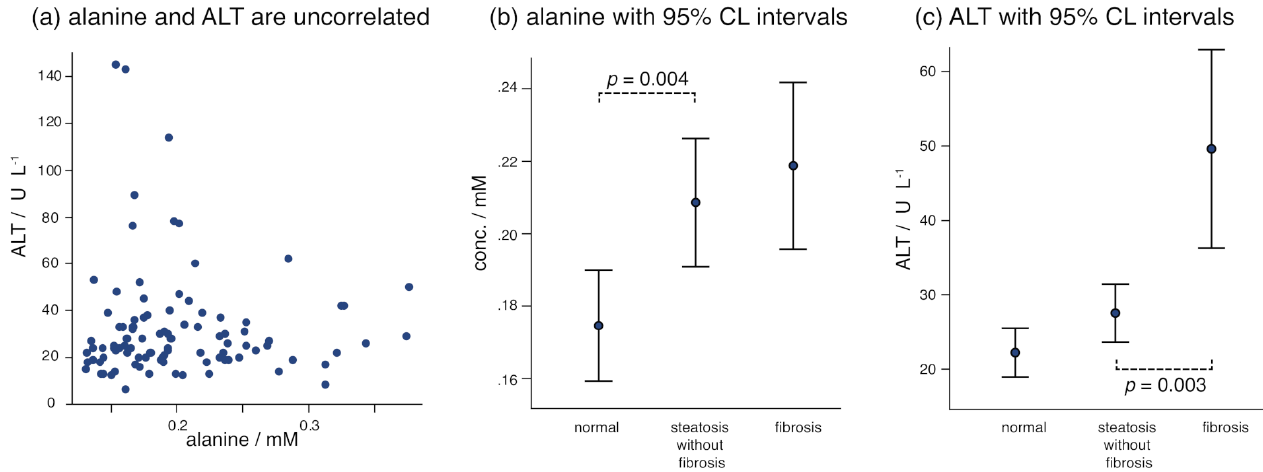
Figure 4. In this study, serum alanine increased particularly upon steatosis, whereas ALT increased more strongly in fibrosis. While energy (TCA cycle) disruption is supported by these data, trends here could also be influenced by urea cycle disruption in steatosis that builds up concentrations of alanine in steatosis, followed by overexpression of ALT in response to